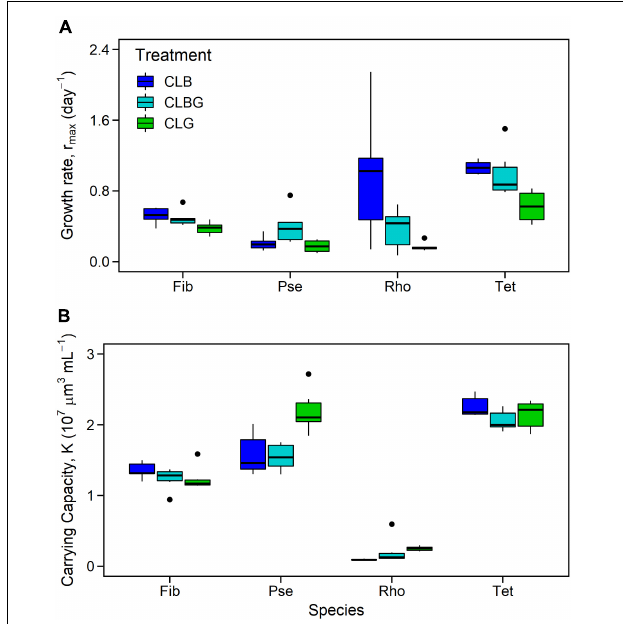
FIGURE 2 | Maximum growth rate (A) and carrying capacity (B) for monocultures [ Fibrocapsa japonica (Fib), Pseudanabaena sp. (Pse), Rhodomonas salina (Rho), and Tetraselmis sp. (Tet)] under constant light. Colors indicate constant light treatment (CLB, constant blue light; CLBG, constant blue-green light; CLG, constant green